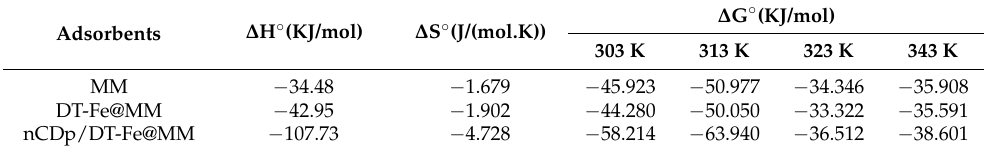
Figure S3. Freundlich isotherm model fitting for adsorption of BPA on different adsorbents (Ad- sorption conditions: Initial Conc. 10–50 mg/L; dosage = 0.02 g/L; t = 120 min; pH = 8), Figure